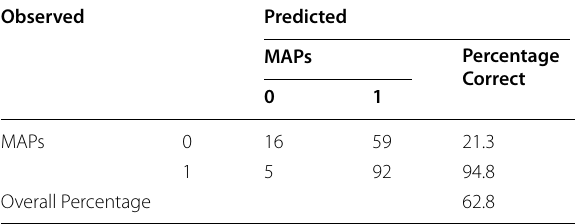
Table G: Classification table for outcome-oriented culture